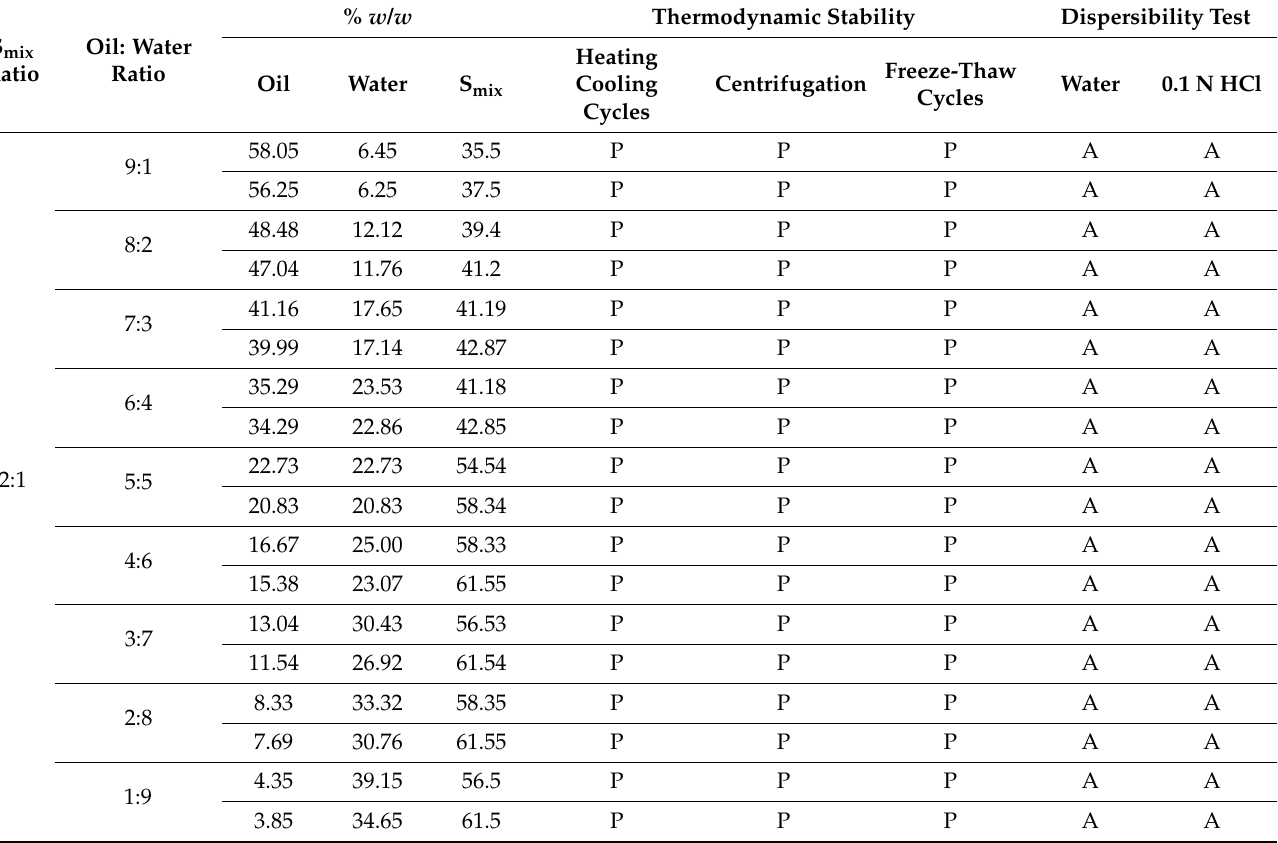
Table 3. Results of the thermodynamic study and dispersibility test of various liquid self- nanoemulsifying drug delivery systems prepared using S mix ratio of